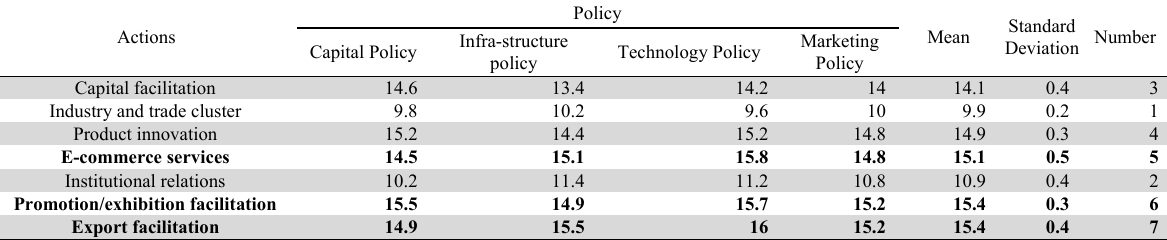
Evaluation Based on Action and Policy